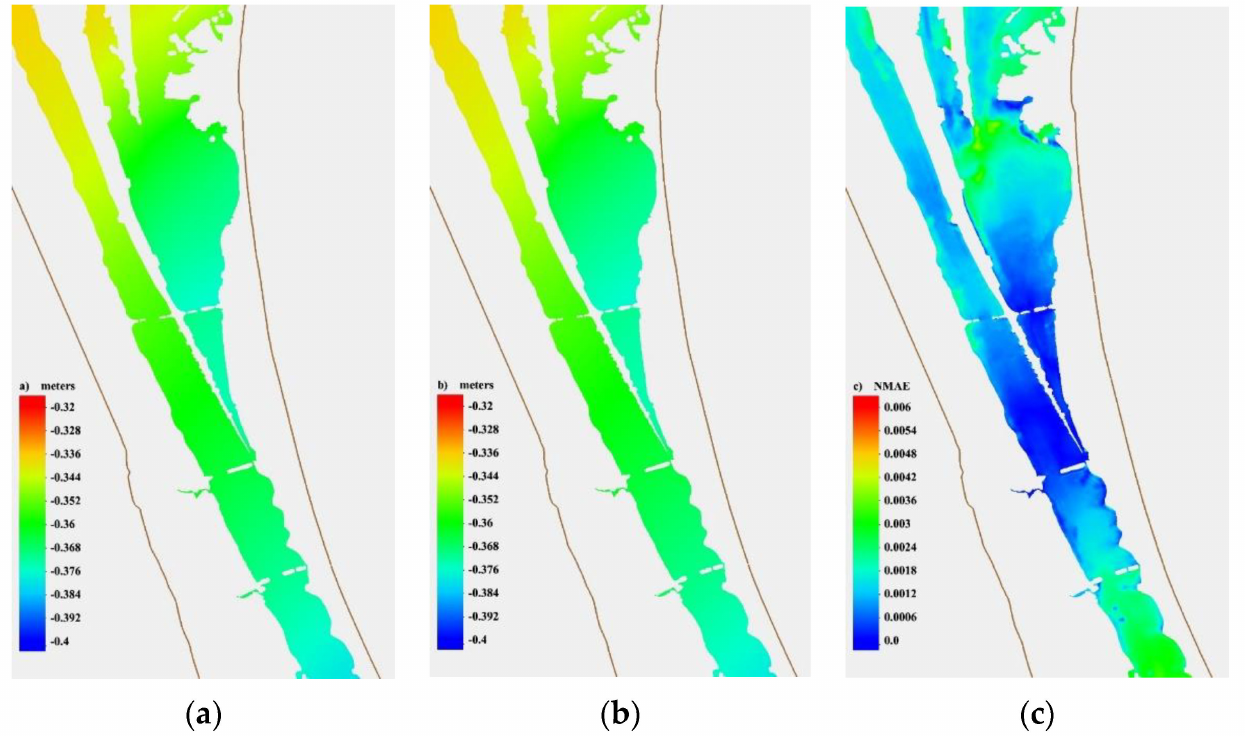
Figure 10. Contours of mean water elevation (meters) at the 60-h mark for ( a ) ADCparam ensem- ble models and ( b ) ADCIRC + SWAN ensemble models, and ( c ) NMAE error in water elevation (abs((SWAN-PARAM)/SWAN)) at the 60-h